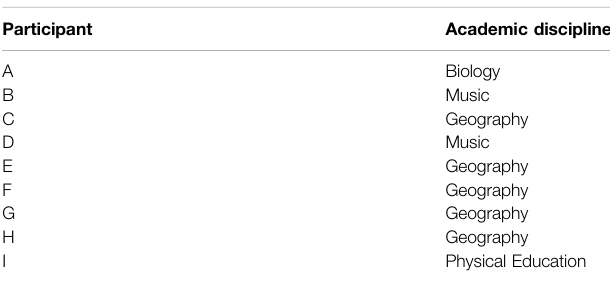
TABLE 1 | Participant pro fi le by academic